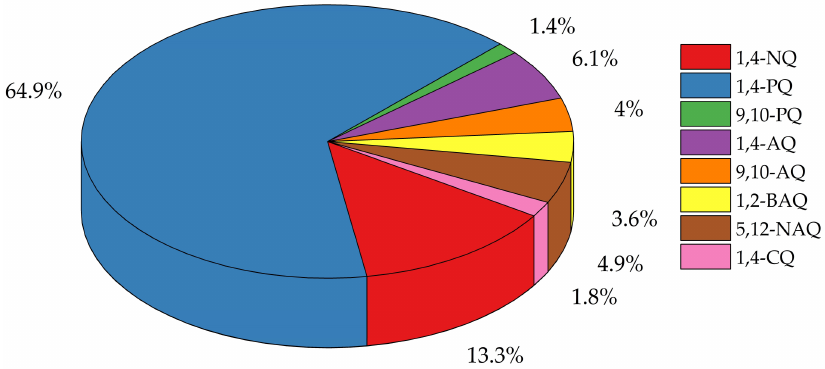
Figure 5. Relative individual contributions by quinone to the total determined concentration (gas + PM 1 ).